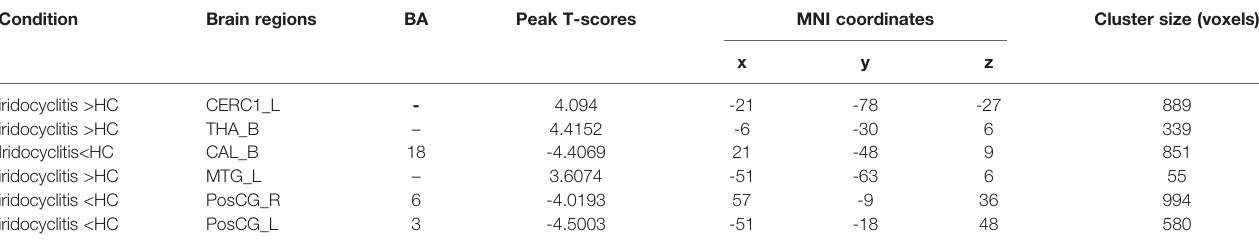
TABLE 4 | Signi fi cant differences in the right V1 between two groups.